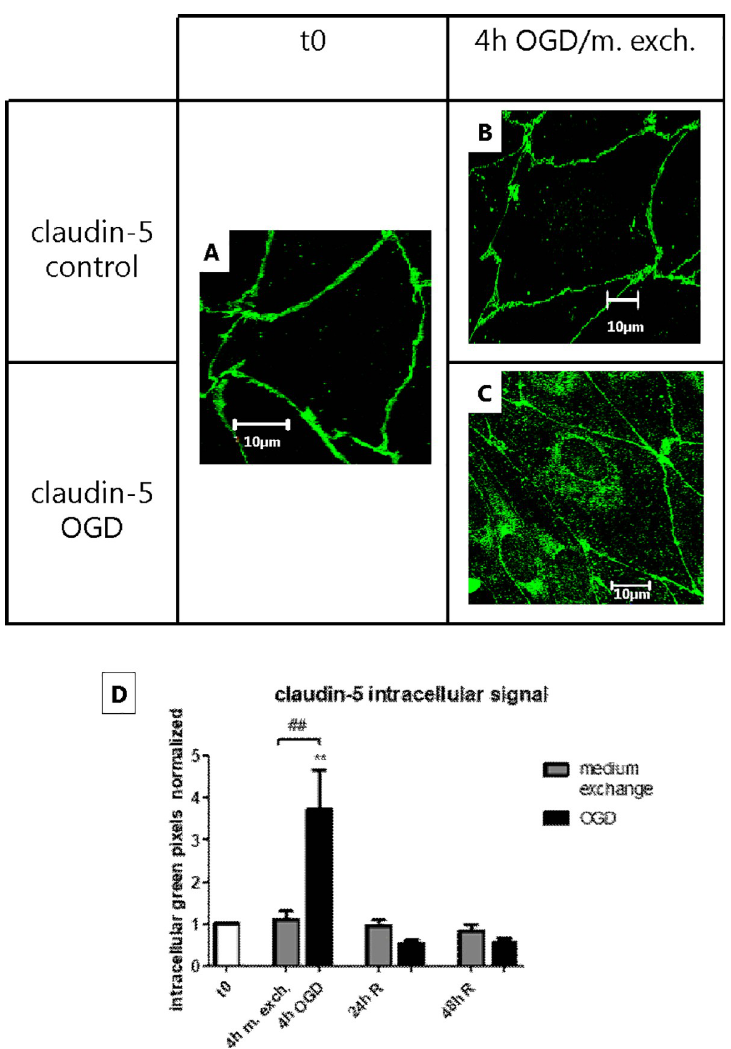
Fig 5. Claudin-5 subcellular localization along the oxygen-glucose deprivation (OGD) and medium exchange. Figs A-C show antibody staining of Claudin-5 under the different treatments. Bars = 10 μ m. N = 1; n = 3. (D) For each condition, the intracellular signal intensity was estimated using ImageJ as described in the “Materials and methods” section. Bar graphs represent means normalized to t0 and error bars are +SEM. (N = 9–12, n = 3–4). The white bar shows the value at t0, the gray bars show the cells subjected to medium exchange, while the black bars show the OGD treated cells. Columns were compared to t0 using one-way ANOVA and Dunnett’s multiple comparison post-test. �� : p < 0.01. Bonferroni’s post-test was utilized to compare each pair of columns. ##: p < 0.01.